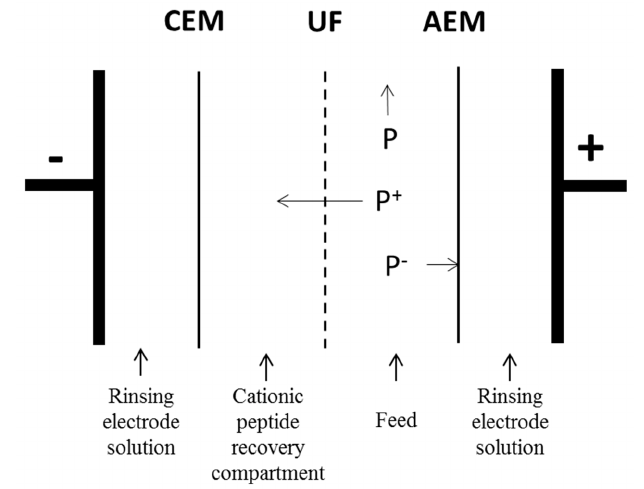
Figure 1. Scheme of electrodialytic cell in cationic configuration. CEM: cation-exchange membrane; AEM: anion exchange membrane; UF: ultrafiltration membrane.